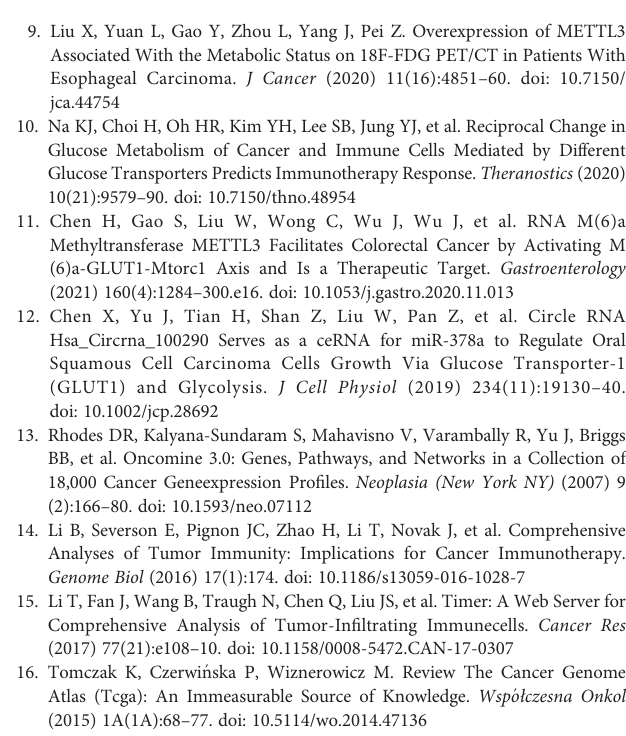
Supplementary Table 1 | GLUT1 expression in cancerous versus normal tissue in ONCOMINE. Supplementary Table 2 | GLUT1 co-expressed genes. Supplementary Table 3 | The GO and KEGG enrichment analysis of GLUT1 related genes. Supplementary Table 4 | The PPI network of